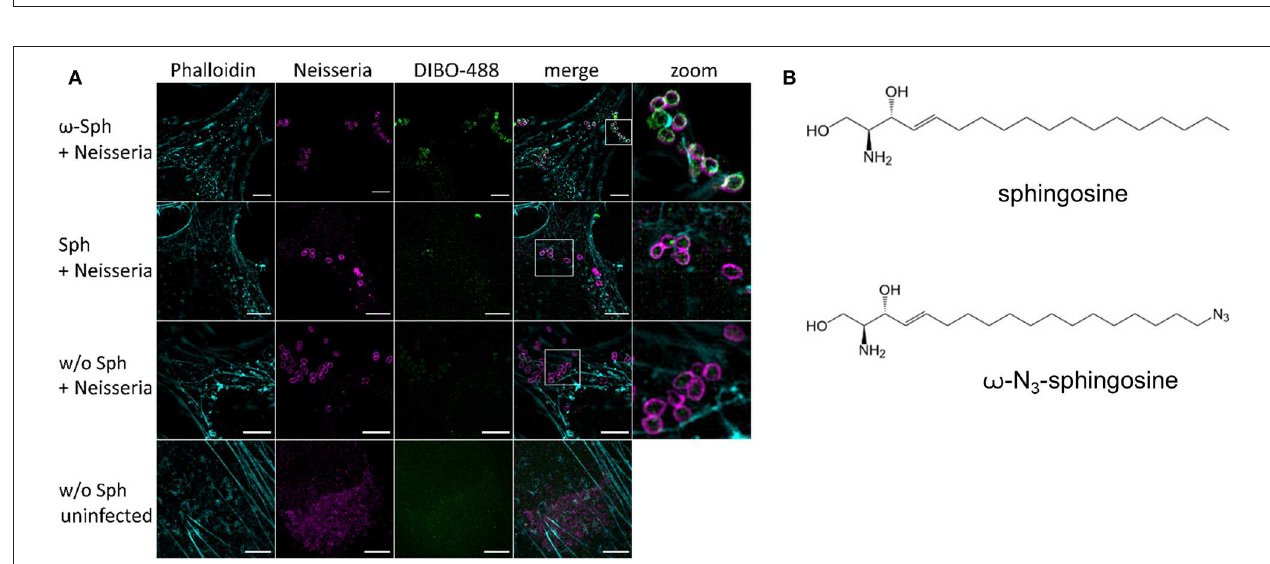
FIGURE 4 | (top left) in the respective mass spectrum. (B) Detection of ω -N 3 -sphingosine 1-phosphate in Chang cells by LC-MS/MS. Chang cells were incubated with either 1-N 3 -sphingosine or ω -N 3 -sphingosine (10 µ M) for 17h. Lipid extracts were analyzed by selected reaction monitoring (SRM) after positive electrospray ionization (ESI + ). As expected, no phosphorylation product could be detected for 1-N 3 -sphingosine (not shown). On the other hand, both ω -N 3 -sphingosine (upper chromatogram) and ω -N 3 -S1P (lower chromatogram) were present in lipid extracts of Chang cells stimulated with ω -N 3 -sphingosine. Assuming similar MS/MS responses for precursor and phosphorylation product, a conversion of about 20% occurred under the given experimental conditions. Peaks are labeled with retention time. Structural formulas and MS/MS fragmentations monitored are given as insets. CID, collision-induced dissociation.